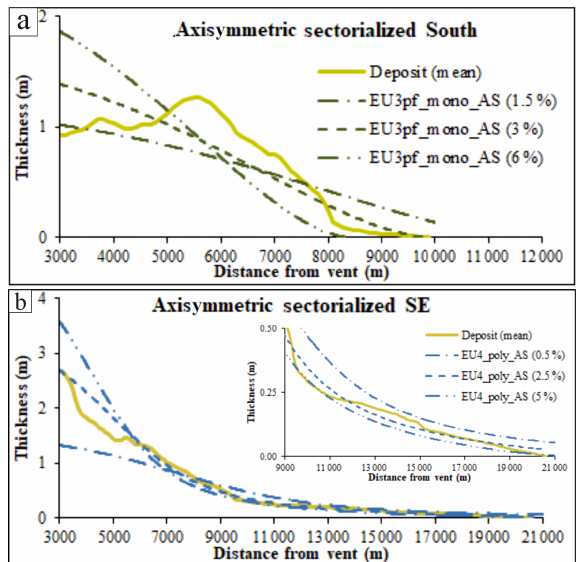
Figure 8. Inundation area of the simulations of the EU3pf (a, b) and EU4b/c (c, d) units. The dashed lines represent the theo- retical isopachs (in m) of the simulated deposit. Vent location (red triangle), vent uncertainty area (red line) and SV caldera (orange dashed line) as in Tadini et al. (2017). MRLs as in Fig. 3. The DEM used in the simulations and as a background derives from Tarquini et al. (2007) according to the modifications explained in Sect.